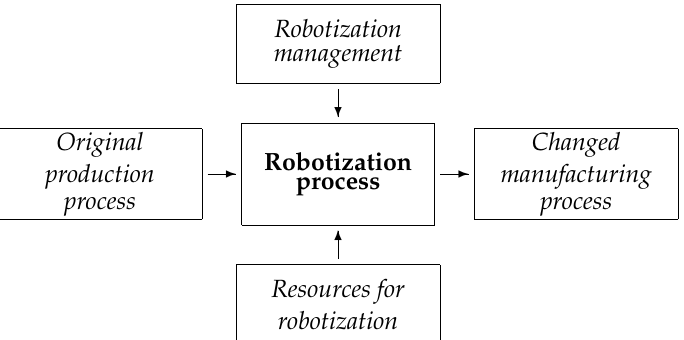
Figure 3. Economic and managerial model of the robotization process.